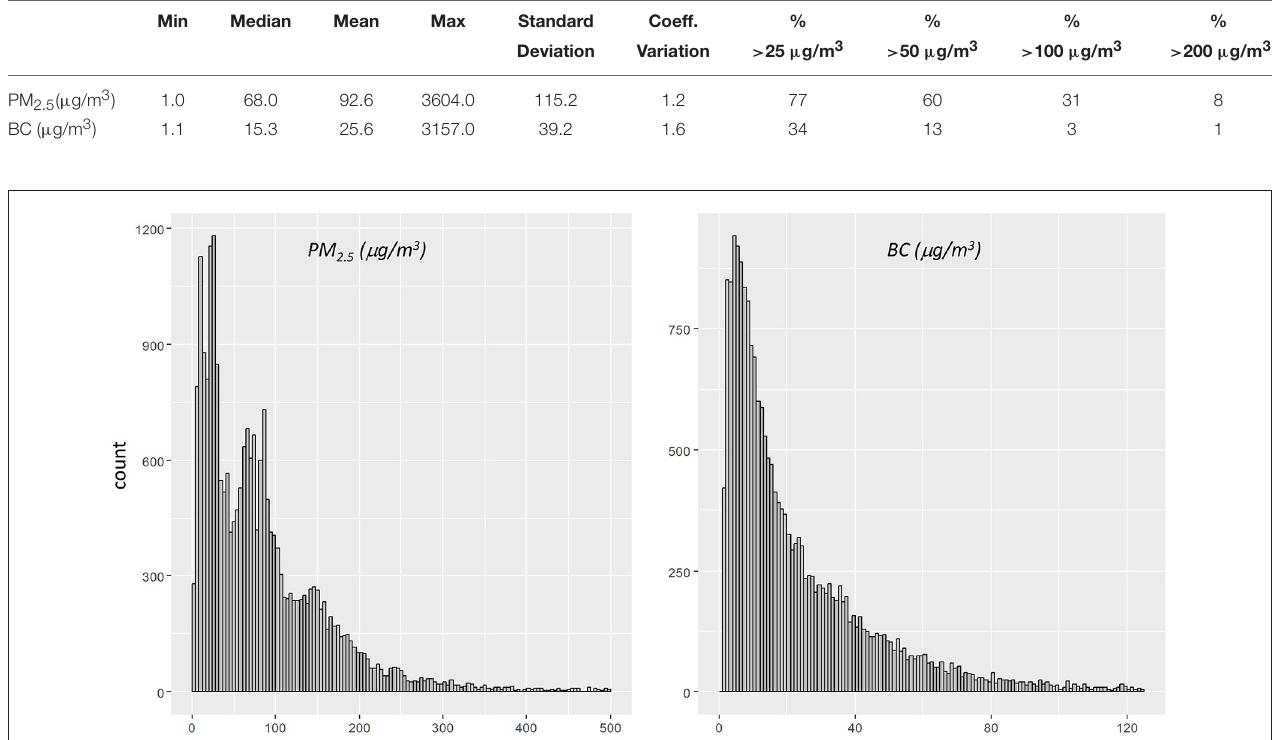
Frontiers in Environmental Science |